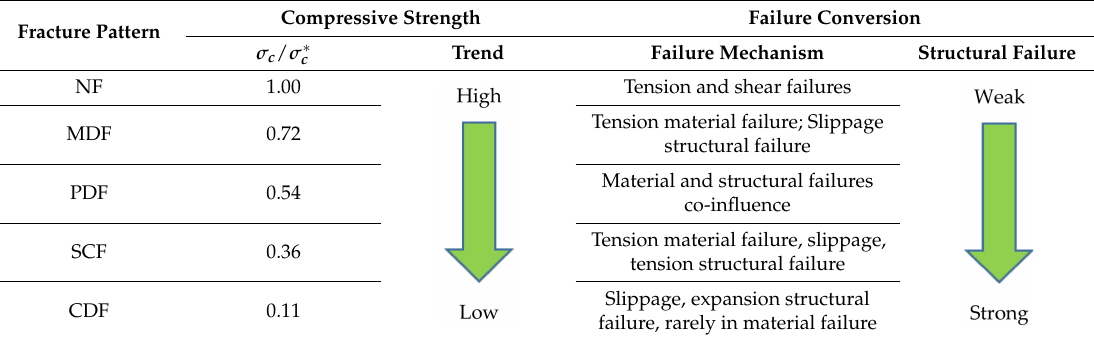
Table 5. Failure